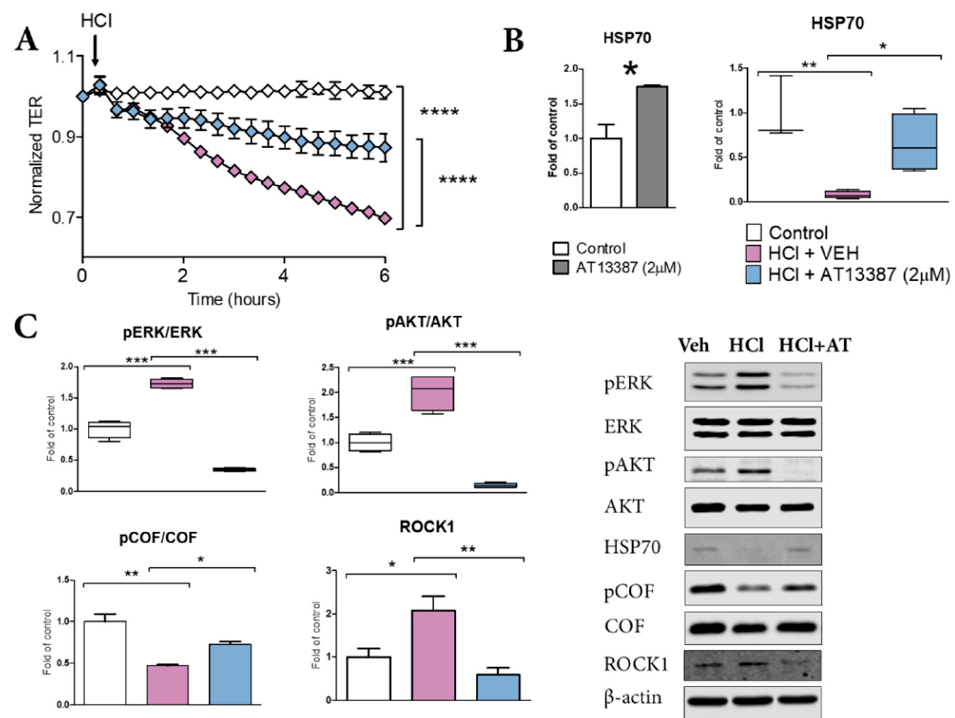
Figure 5. AT13387 blocks HCl-induced loss of endothelial barrier integrity . ( A ) Human Lung Microvascular Endothelial Cells (HLMVEC) were grown on gold electrodes (8WE10+) till stable resistance (>800 Ω ) was achieved, pre-treated with vehicle or 2 µM AT13387 for 4 h, then challenged with 0.02N HCl. ( B ) HSP70 levels in control cells and in cell incubated for 4 h with 2 µM AT13387; HSP70 levels in cell pretreated with AT13387 2 µM or vehicle and challenged with HCl 0.2N. ( C ) pERK1/2, pAKT/AKT, p-Cofilin and ROCK1 in HLMVEC pre-treated with 2 µM AT13387 for 4 h and then exposed to HCl for 1 h were analyzed by Western blotting. Data is represented in box and whickers plots or in bar graphs with means ± SEM; n = 3–4 per group; *: p < 0.05; **: p < 0.01, ***: p < 0.001, ****: p < 0.0001 with 2-way ANOVA and Bonferroni’s (A), 1-way ANOVA and Tukey’s (B, C).